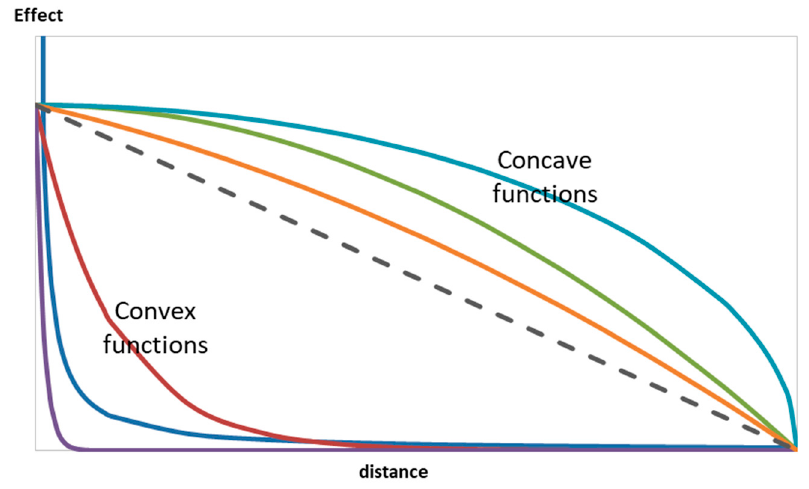
Figure 1. A schematic illustration of the shape of distance–decay functions. Different patterns of distance–decay functions for different distance effects have sel- dom been addressed in previous studies. In this study, the optimal distance–decay func- tions for both the flood risk and MRT accessibility effect are defined as curves with minimum residual sum of squares (RSS). For each distance–decay function, a corresponding distance variable is generated. By applying each distance variable to an identical regression model, the RSS measures the goodness of fit of the distance–decay function. The distance–decay function with the minimum corresponding RSS is identified as the optimal function to describe how perceptions change as distance increases.